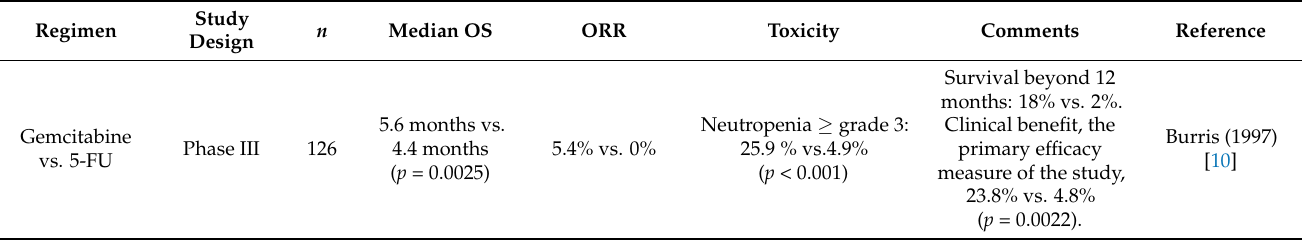
Table 1. Select trials evaluating efficacy and safety of first-line chemotherapy in metastatic pancre- atic